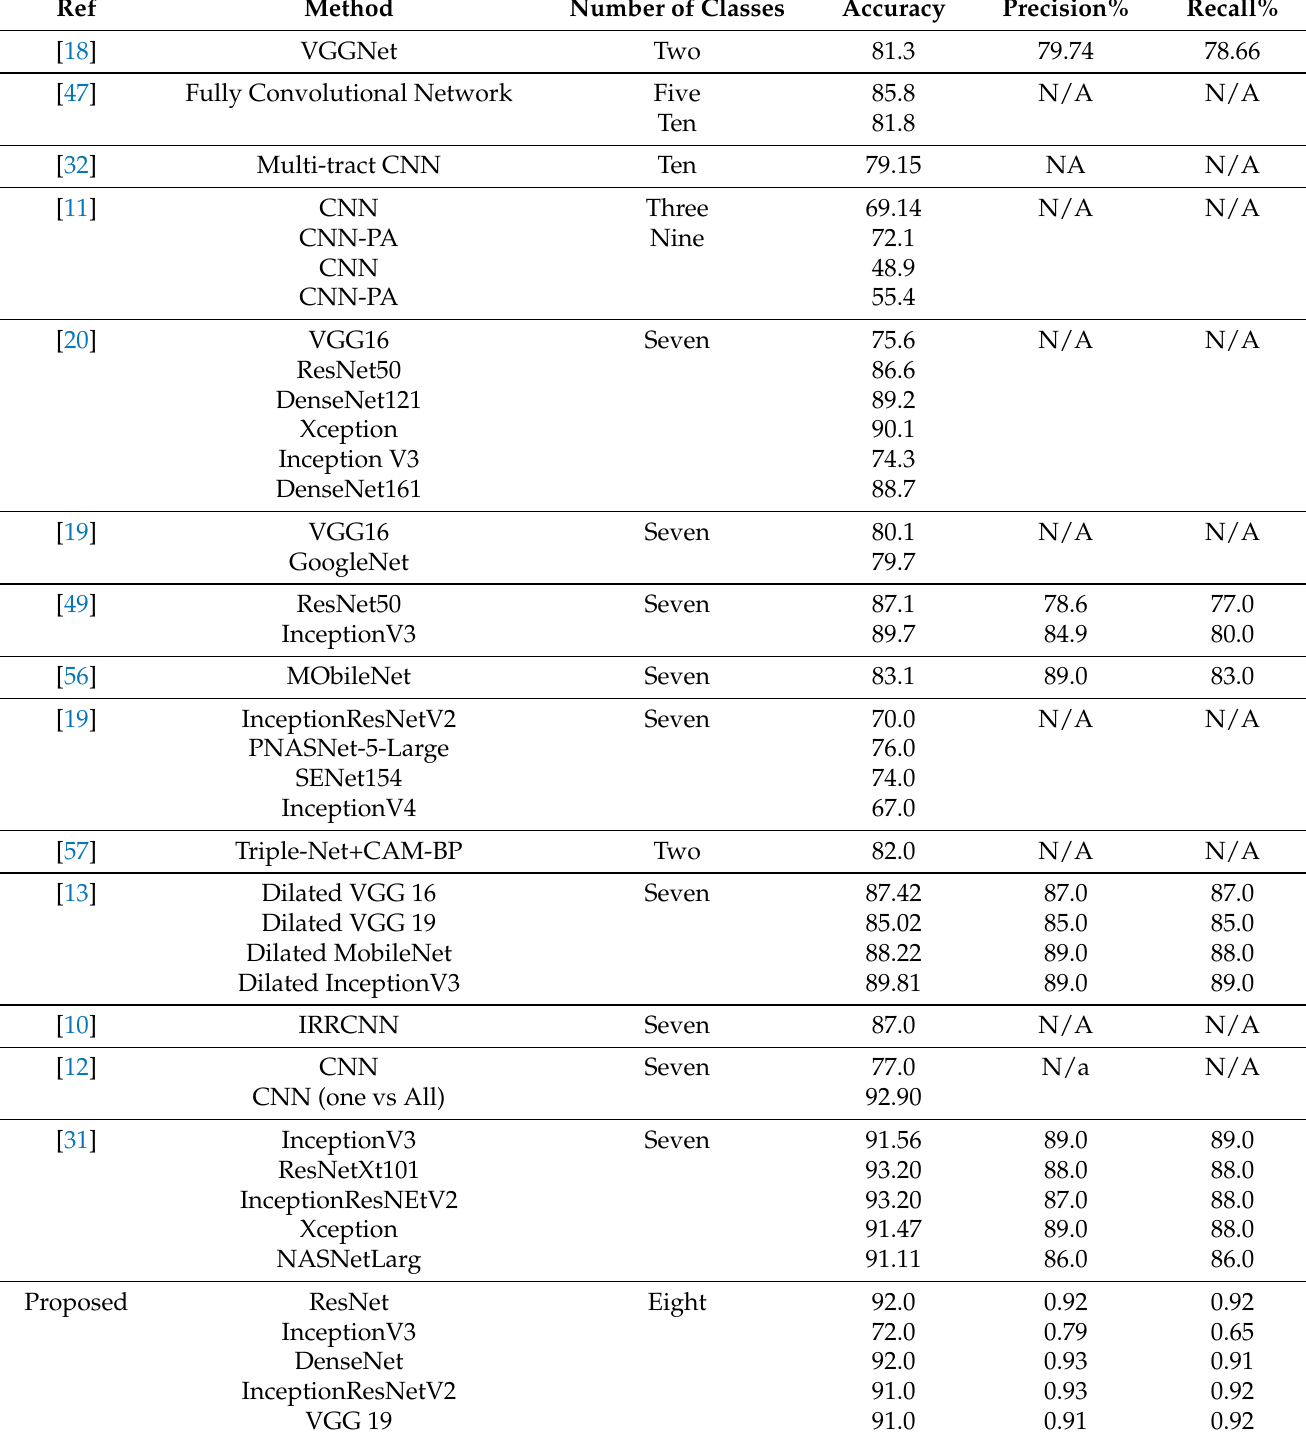
Table 4. Performance comparison with other deep learning-based